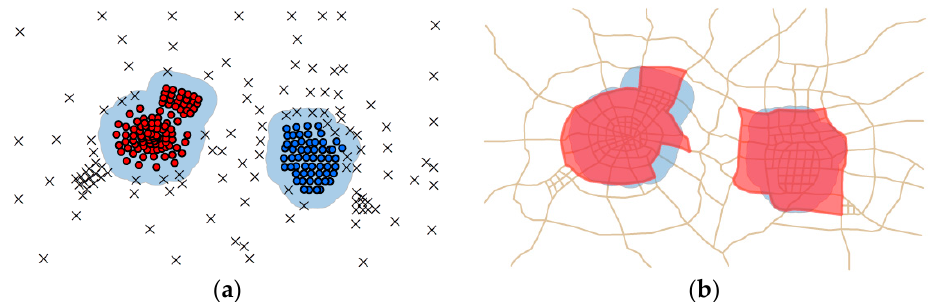
Figure 6. ( a ) Covering discs (CD) boundaries of the clusters; ( b ) main center areas.